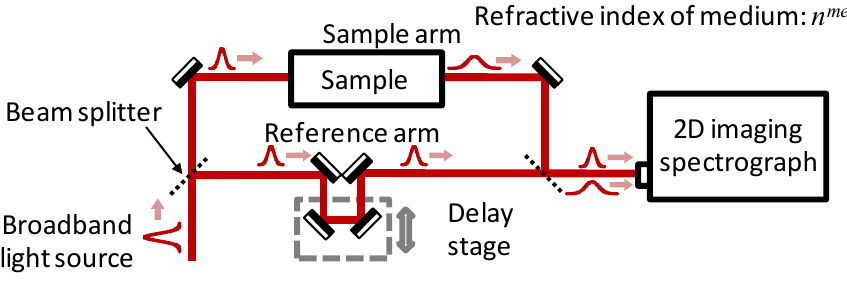
Figure 5. Schematic experimental layout of the SSRI technique.